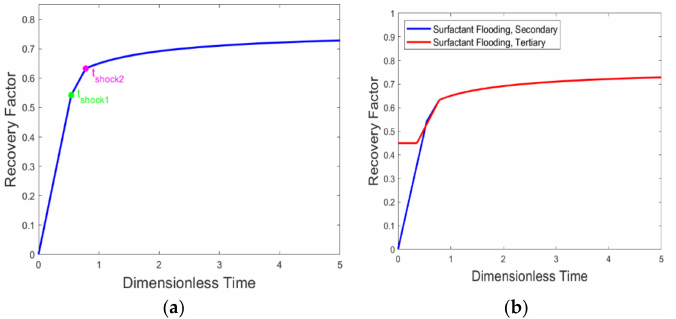
Figure12. ( a )Cumulativeoilrecoveryhistoryduringthesecondaryrecoveryprocessand( b )comparison of cumulative oil recovery during the secondary and tertiary processes for continuous surfactant injection with no surfactant adsorption and no surfactant